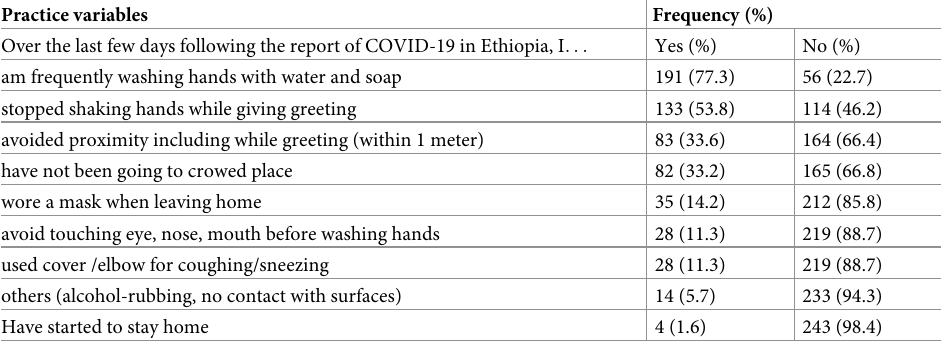
Table 3. JUMC visitors COVID-19 preventive practices, Jimma, Ethiopia, March 2020 (n = 247). Practice